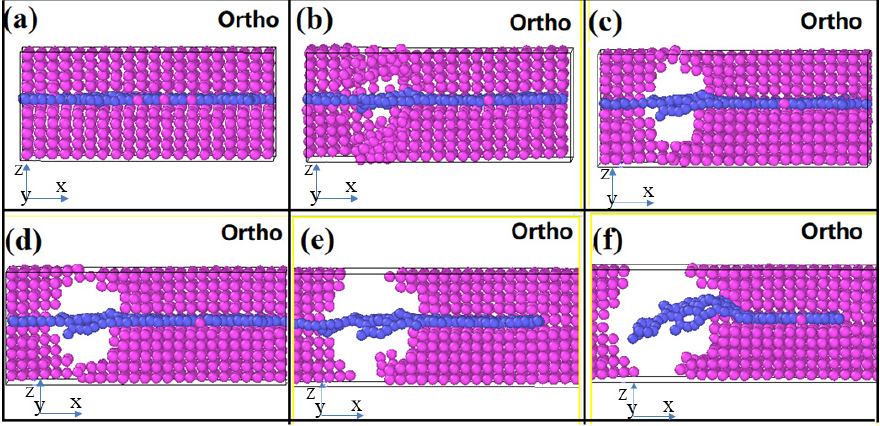
Figure 6. Diagram of single-layer graphene/aluminum composite in the tensile failure process, ( a – f ) represent the process of matrix cracking until material failure during